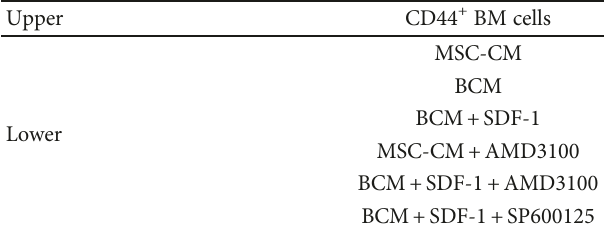
Table 2: Set-ups in transwell